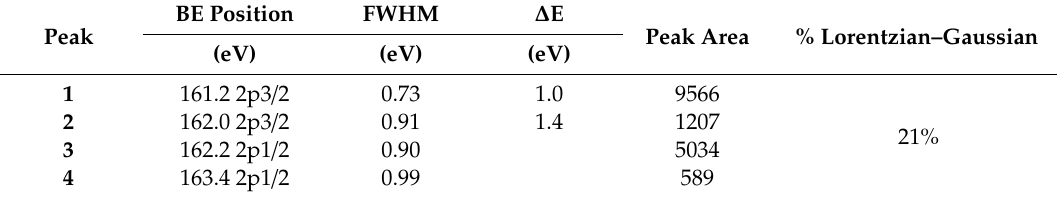
Table 3. Details of the fitting peaks of S after the HER